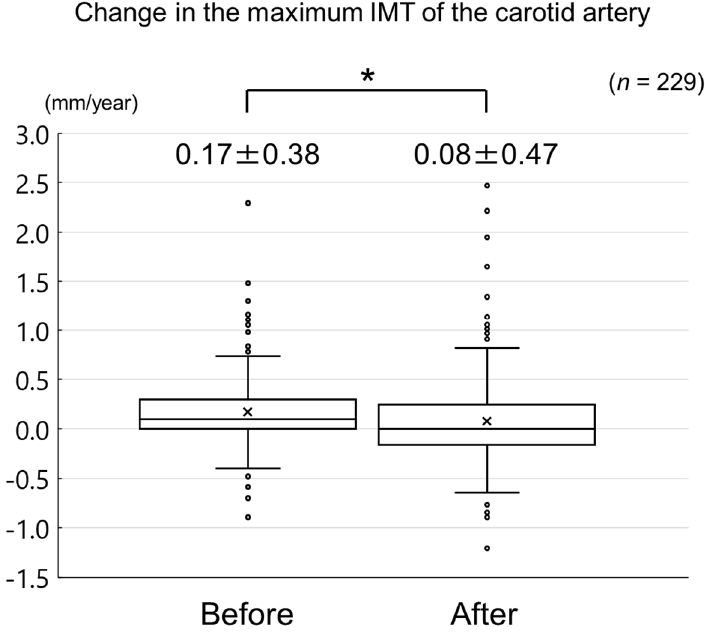
Figure 7. Change in carotid maximum IMT during the 12 months before and after the initiation of evolocumab treatment. * p = 0.02.